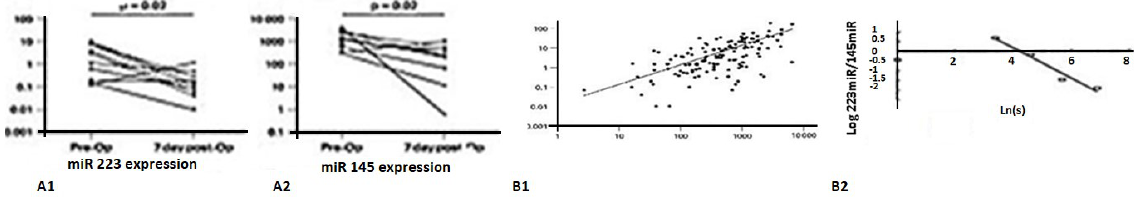
Fig. 4. The differential expression of microRNAs in patients with breast cancer. Changes of miR-223(A1) and miR- 145(A2) plasma levels in breast cancer patients (n=15) relative to normal. Correlation between miR223 and miR145 in these patients (B1). Logaritmic value of miR-223 expression level relative to miR-145 (B2). Statistically significant differences were determined using Wilcoxon tests.